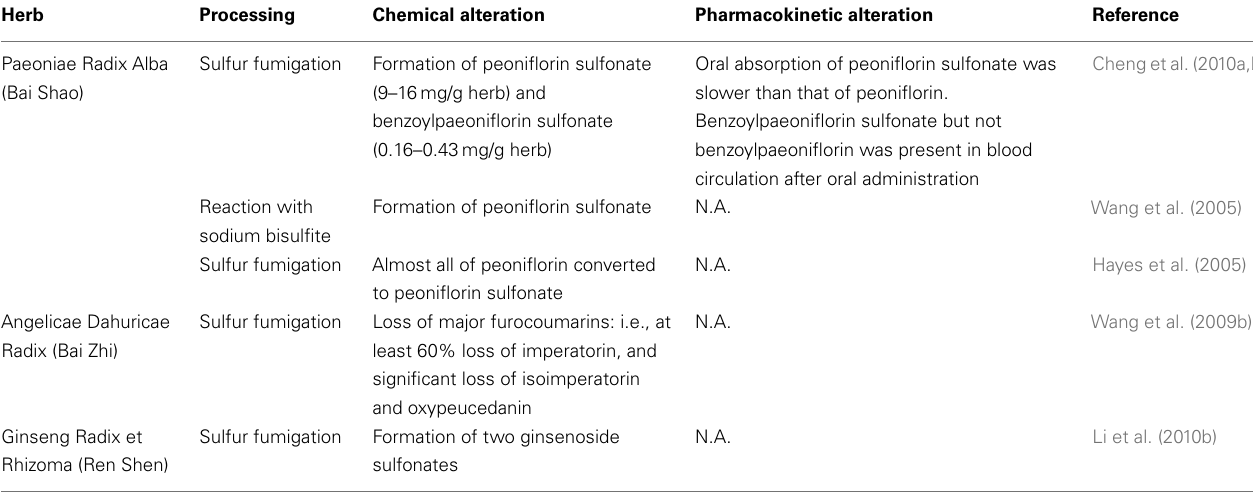
Table 1 | Effects of sulfur fumigation or reaction with sulfiting agents on chemical constitution and pharmacokinetics of variousTCM